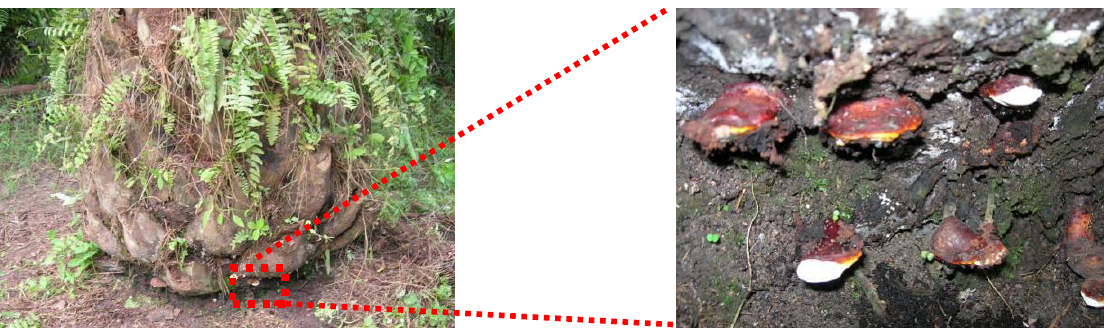
Figure 1. Ganoderma fruiting bodies (mushrooms) found at the bottom of sick oil-palm